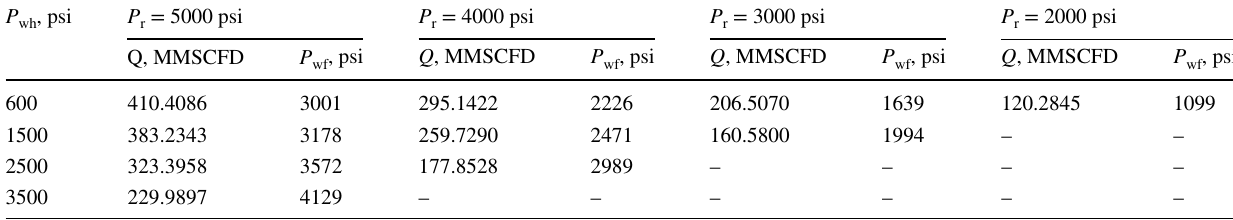
Table 10 Operating points through nodal analysis for 28-layer reservoir model P wh ,